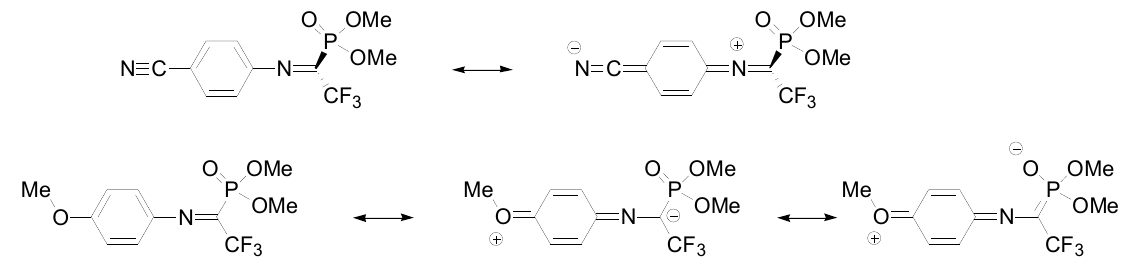
Scheme 2. Different substituent effects of electron delocalization in compounds 6 and 7, stabilizing the transition state structure for the Z,E-isomerization reaction.